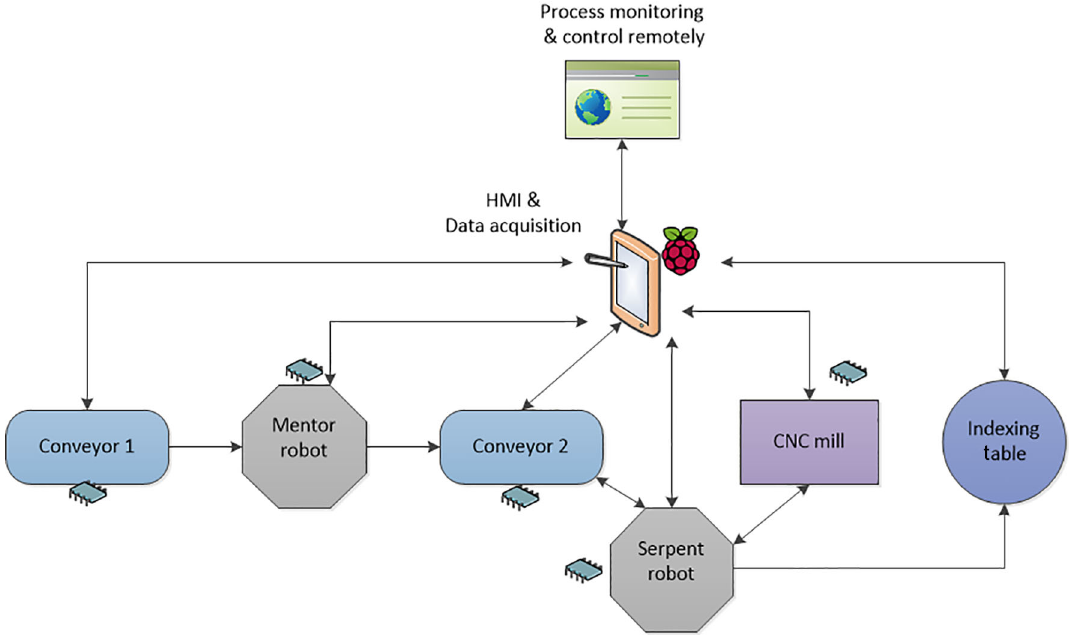
Fig. 6. The proposed control system architecture for the manufacturing test system.